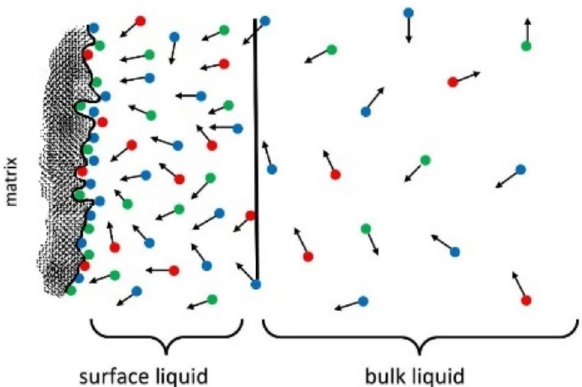
Figure 2. Description of complexity in the surface layer of an interface to model different particles near the surface. The coloured dots (arbitrarily) represent the different particles present and can represent metal ions, nitrate ions, or water molecules with hydrogen and hydroxyl ions. They are attached to the surface, detached, and adsorbed back with different-random